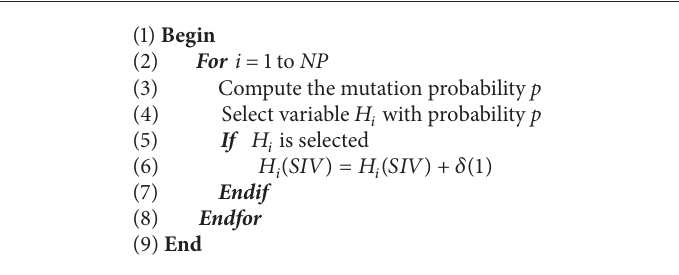
Algorithm 3: Pseudocode of Cauchy mutation